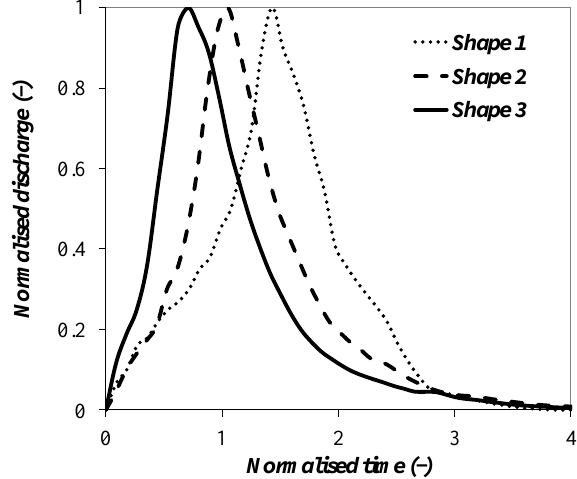
Figure 16. Non-dimensional clustered